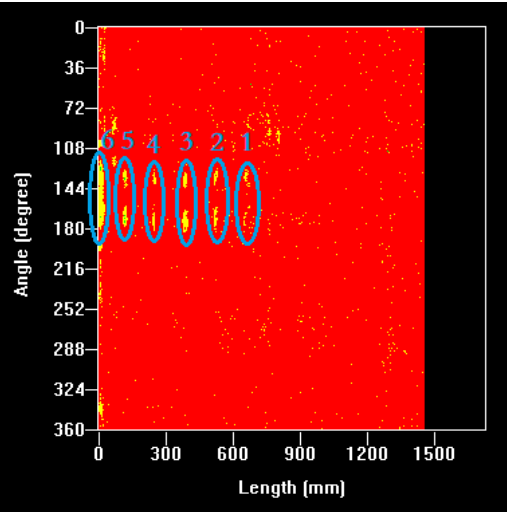
Figure 12. Artificial defects (near-surface defects: 1. ∅ 2 × 10, 2. ∅ 4 × 10, 3. ∅ 6 × 10, 4. ∅ 8 × 10, and 5. ∅ 10 × 10, internal defect: 6. ∅ 10 ×